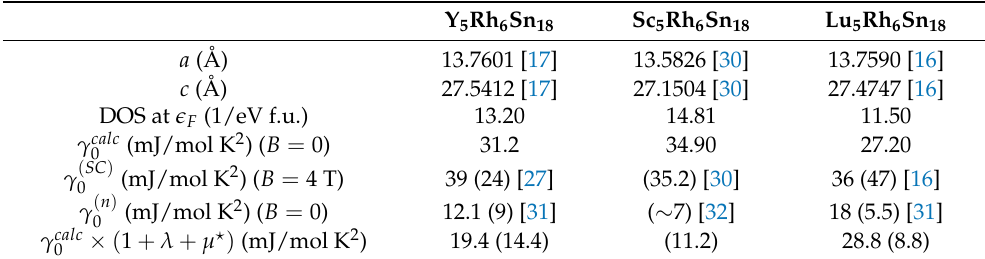
Table 2. Structural characterisation (lattice parameters a and c ), total DOS at the Fermi level, and the electronic specific heat coefficient γ normal state ( T > T c , B = 0), respectively, from the C / T vs. T 2 linear dependence at T = 0. The Sommerfeld coefficients in brackets are assigned to the off-stoichiometry samples with vacancies δ , respectively.